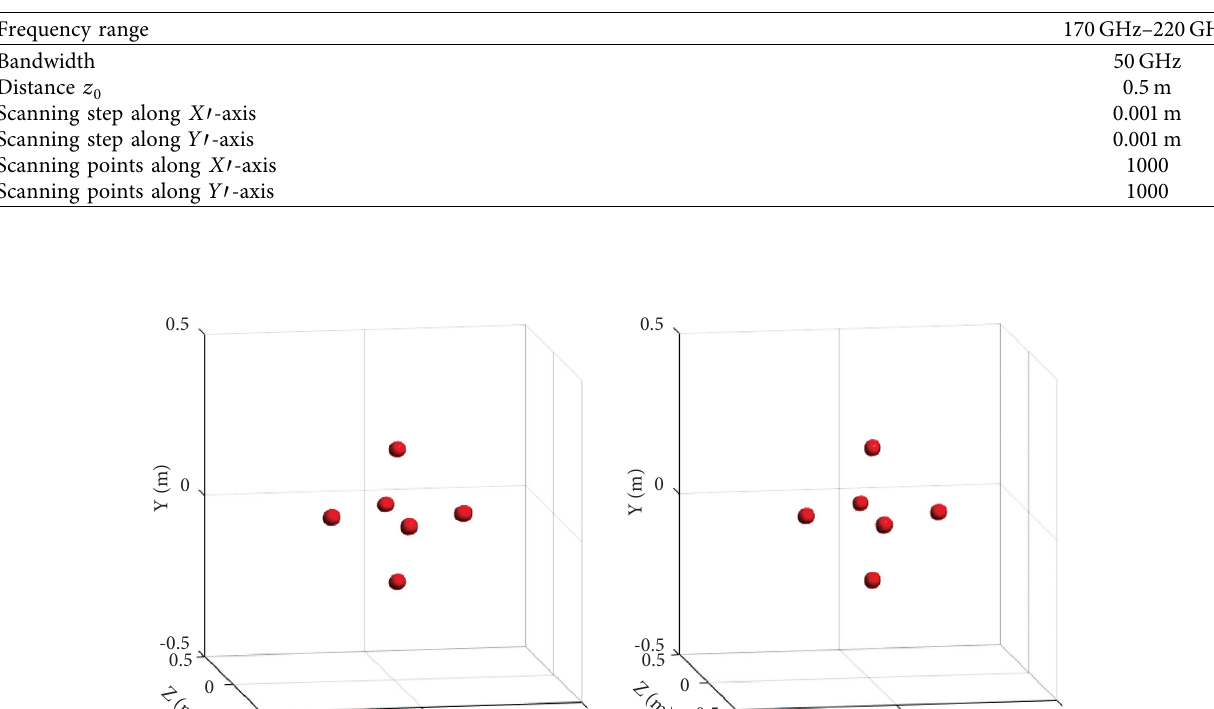
Table 3: Simulation parameters.